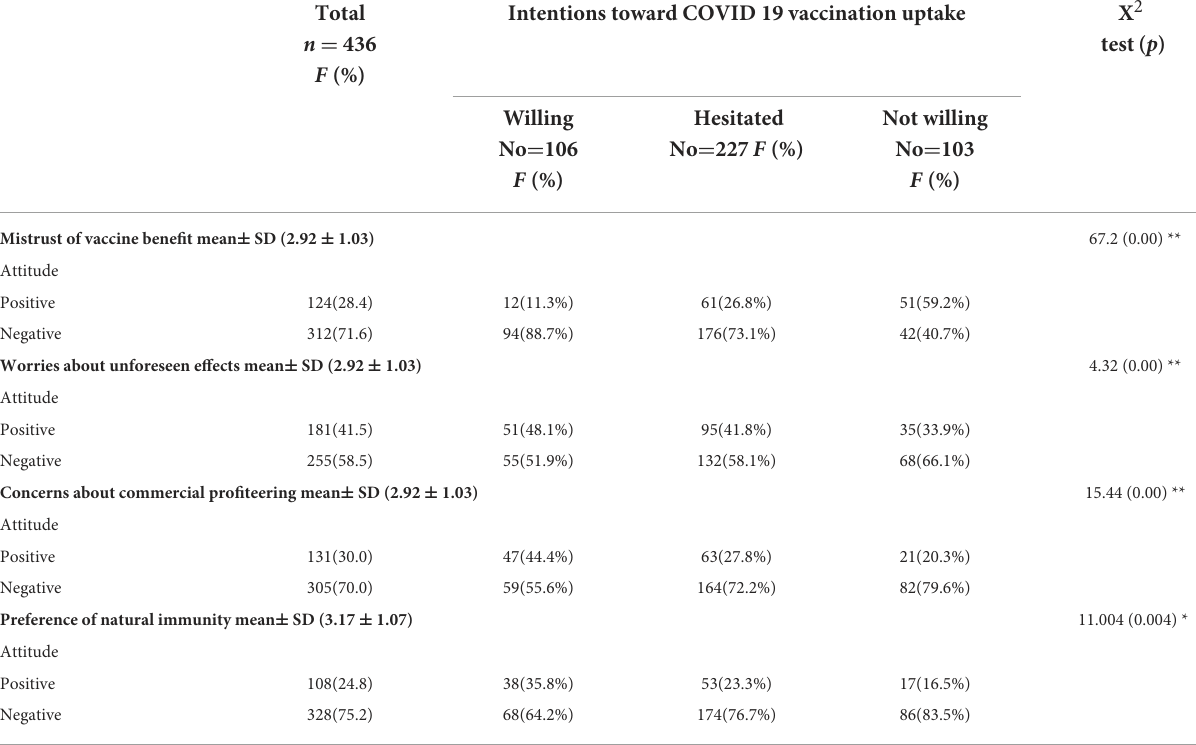
Total Intentions toward COVID 19 vaccination uptake X 2 n = 436 test ( p ) F (%) Willing Hesitated Not willing No = 106 No = 227 F (%) No = 103 F (%) F (%)